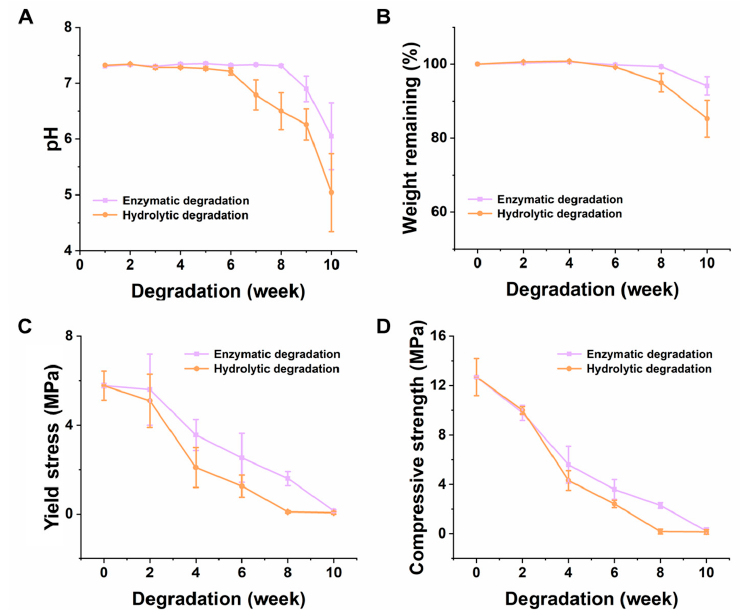
Figure 5. The effect of various physicochemical properties during the degradation of the PLGA scaffolds. Change of ( A ) pH value, ( B ) weight, ( C ) yield stress, and ( D ) compressive strength, with time ( n = 5).